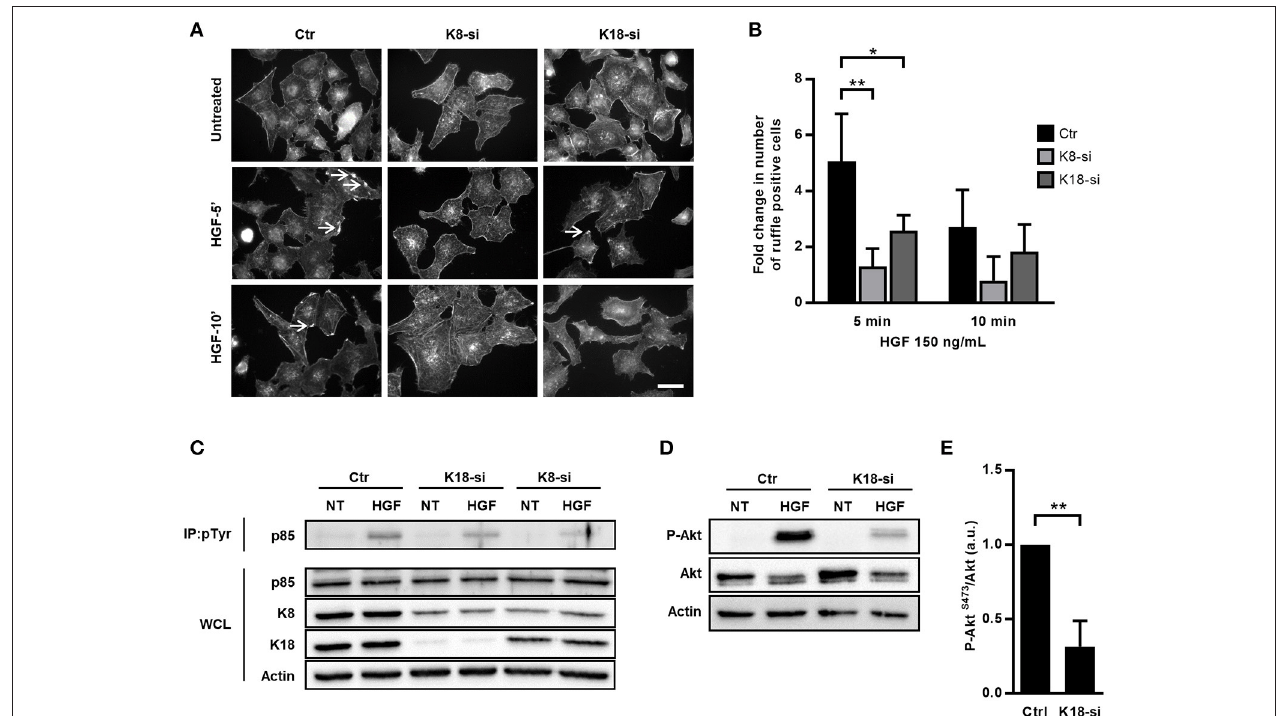
FIGURE 4 | K8 and K18 mediate cMet downstream signaling. (A) Immunofluorescence microscopy images of control (Ctr), K8 (K8-si), or K18 (K18-si) depleted HeLa cells left untreated or incubated with HGF (150ng/ml) for 5 and 10min (HGF-5 ′ and HGF-10 ′ ). Cells were fixed and stained for actin with TRITC-phalloidin. Images show the actin-rich membrane ruffles (arrows) induced by the HGF stimulation of cMet. Scale bar, 20 µ m. (B) Quantification of actin-rich membrane ruffles in Ctr, K8- and K18-depleted cells. Cells without ruffles were considered ruffle-negative, whereas cells with at least one actin-rich membrane ruffle were scored as ruffle-positive. Values result from four independent experiments and are expressed as fold change with respect to untreated control cells. (C) Ctr, K8 and K18-depleted HeLa cells were incubated with 150ng/ml HGF for 5min, washed and lysed. Tyrosine phosphorylated proteins were immunoprecipitated (IP: pTyr) from whole cell lysates (WCL) and p85 was detected by immunoblot (p85) in IP fractions and WCL. Detection of actin was used as loading control. (D) Immunoblot to detect P-Akt (S473), total Akt and actin on total extracts of Ctr and K18-depleted HeLa cells left untreated (NT) or incubated with 150ng/ml HGF for 5min. (E) Densitometry analysis of the ratio of P-Akt (S473) over total Akt, in conditions of HGF stimulation. For control cells the value was arbitrarily fixed to 1. Values represent the mean ± S.E. of three independent experiments. Statistically significant differences are indicated: * p < 0.05 and ** p <